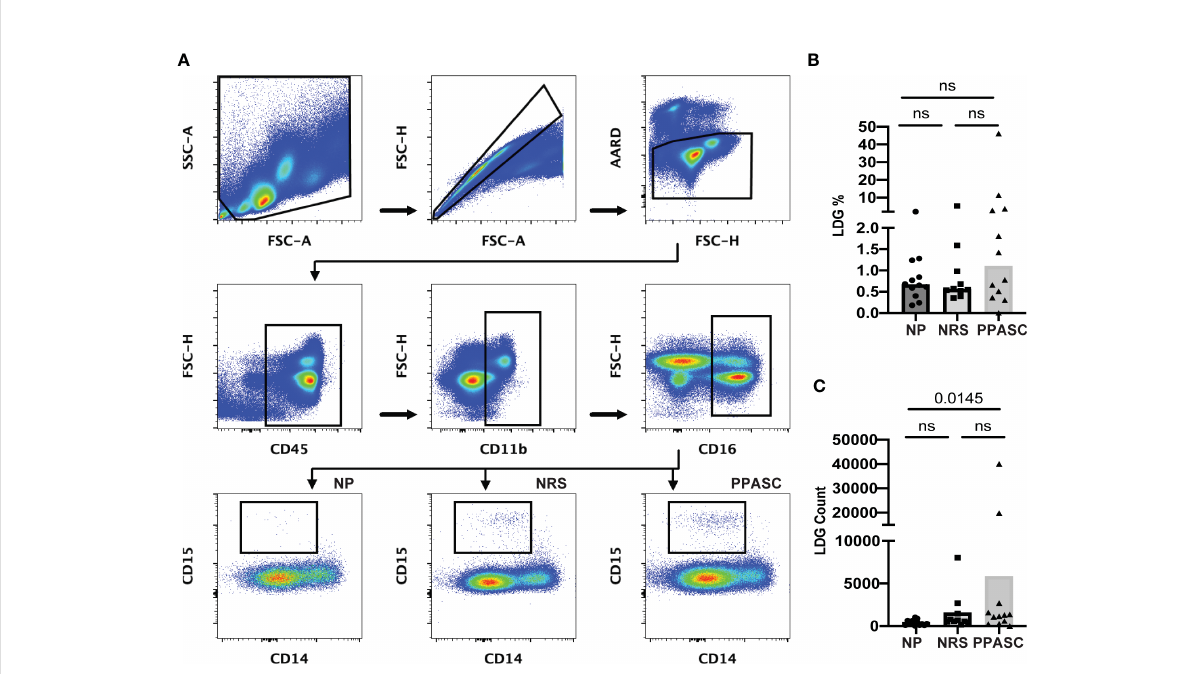
FIGURE 1 Circulating low-density granulocytes (LDGs) fl ow cytometry gating strategy. Representative gating for LDGs identi fi ed by CD15 expression after gating on CD45 + CD11b + CD16 + CD14 - cells. Boxed regions within scatter plot represents LDGs within NP (n = 12), NRS (n = 10), and PPASC (n = 12) groups (A) . Percentage of LDG (B) and total count of LDGs in NP, RC, and PPASC groups (C) . Graphs are shown as bar with scatter dot plots. Comparisons between groups were performed using Mann-Whitney U test. ns, non-signi fi cant, p >